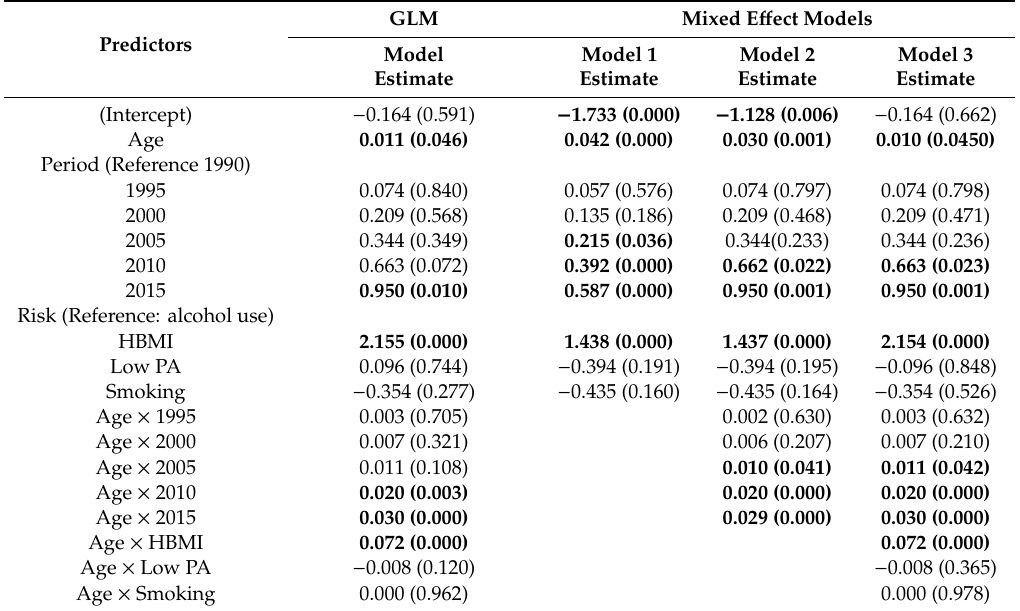
Table 1. Generalized linear model (GLM) and mixed-e ff ect model estimates ( p -value) predicting breast cancer mortality (BCM) among Chinese women. AIC—Akaike information criterion; BIC—Bayesian information